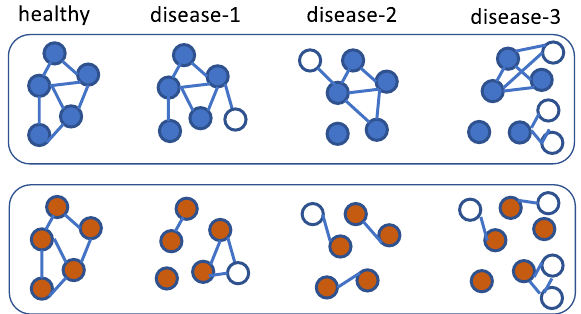
Figure 2. A toy example demonstrating module resilience. The healthy network contains two modules, the blue module containing five species shown as blue nodes and the red module also contains five species shown as red nodes. The blue module, whose composite nodes tend to remain in the same module across diseased networks, has higher resilience (resilience score = 0.8) than the red module (resilience score =